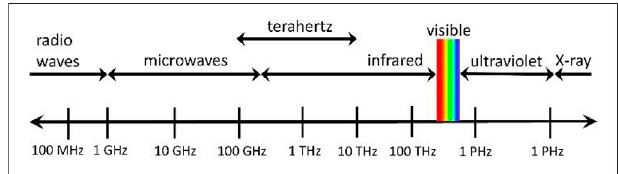
FIGURE 7 | Electromagnetic